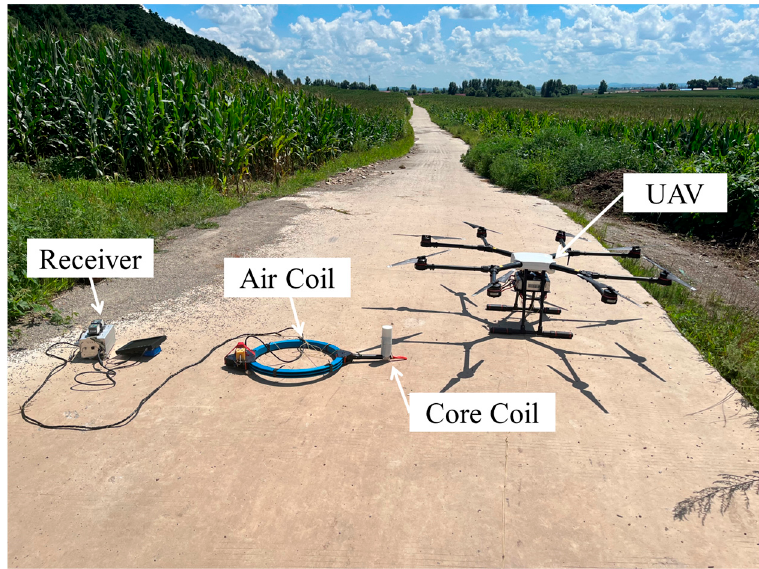
Figure 11. Overview of the field experiment.